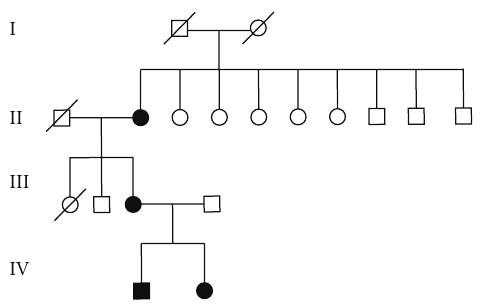
Figure 1: Pedigree showing the autosomal dominant pattern of inheritance of TCS in the family. Table 1: Phenotypic features of the a ff ected family